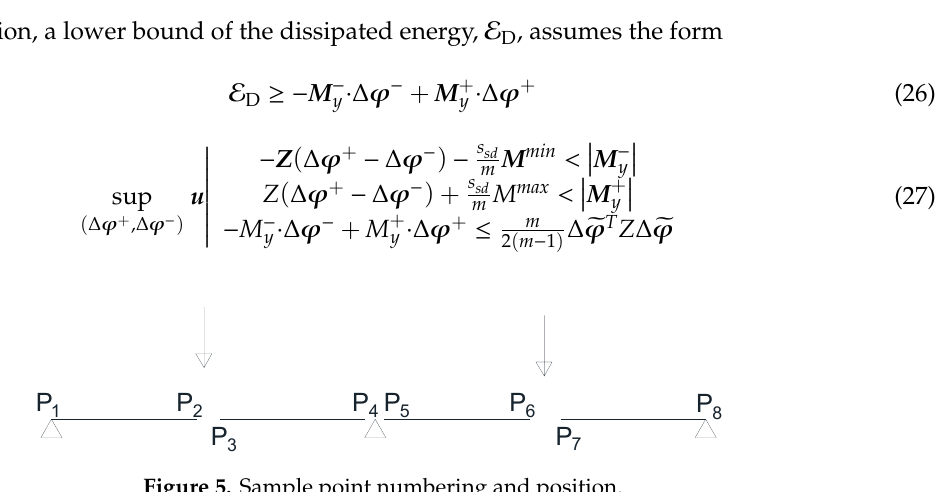
Figure 5. Sample point numbering and position .